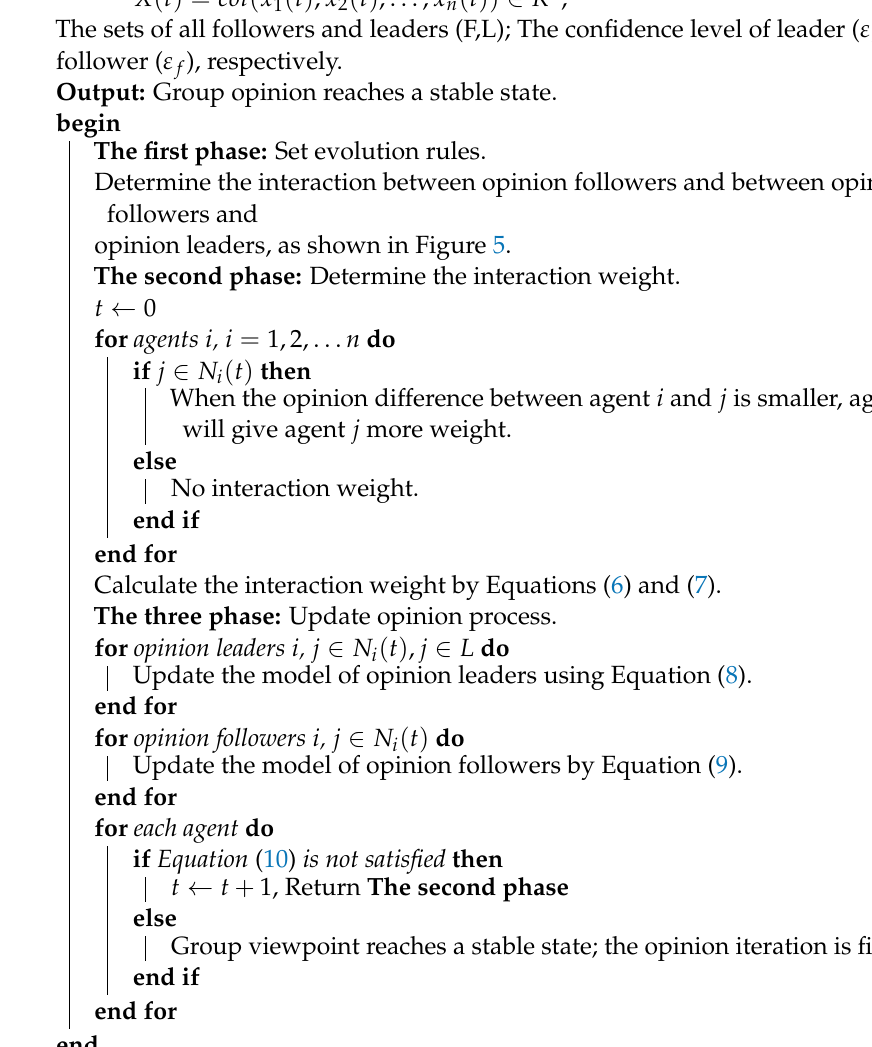
Algorithm 4: The HK-based leader–follower opinion interaction and updating